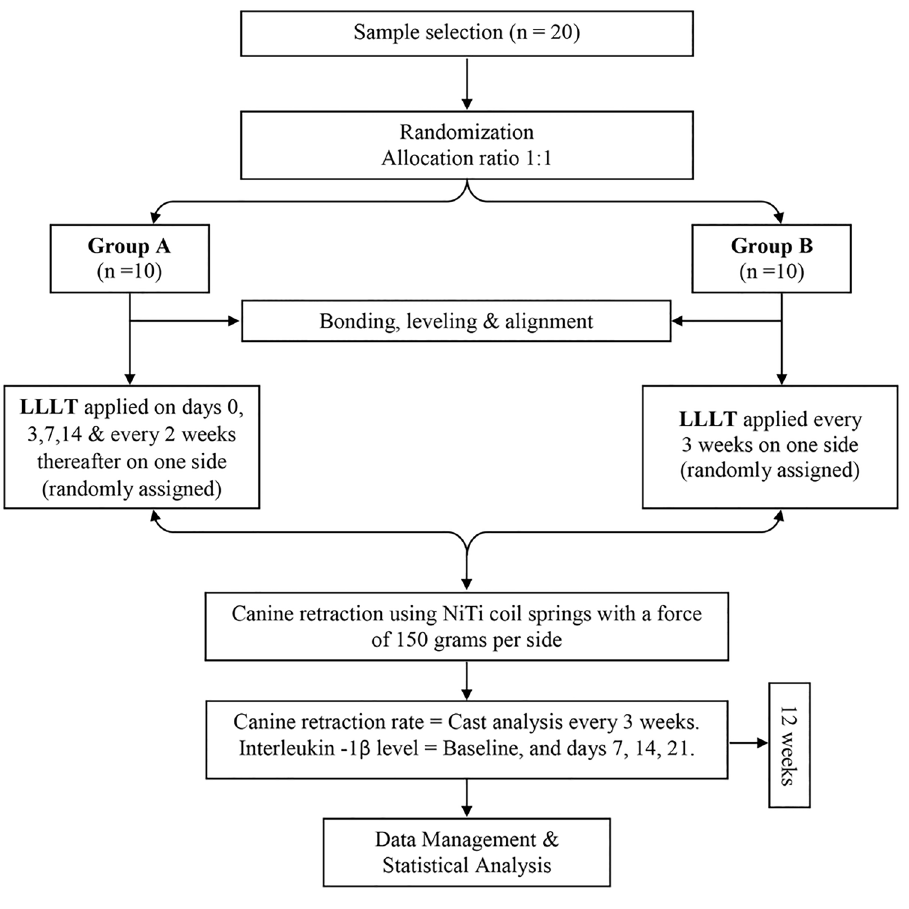
Figure 5. Research design